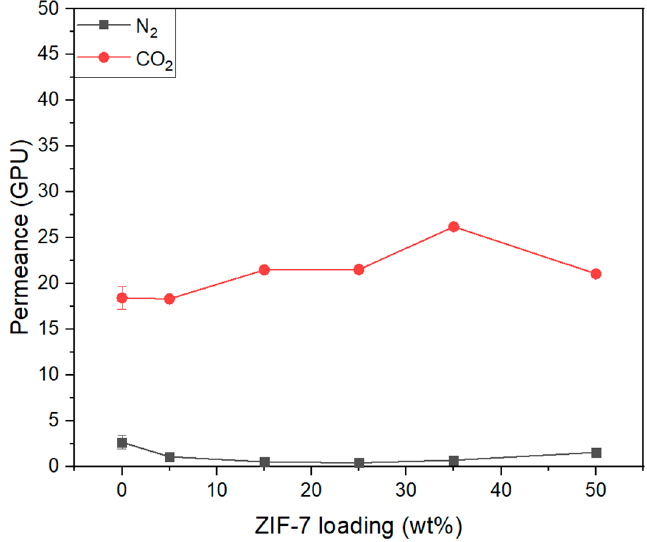
Figure 14. Gas permeance of Pebax ‐ 2533/ZIF ‐ 7 composite membranes.